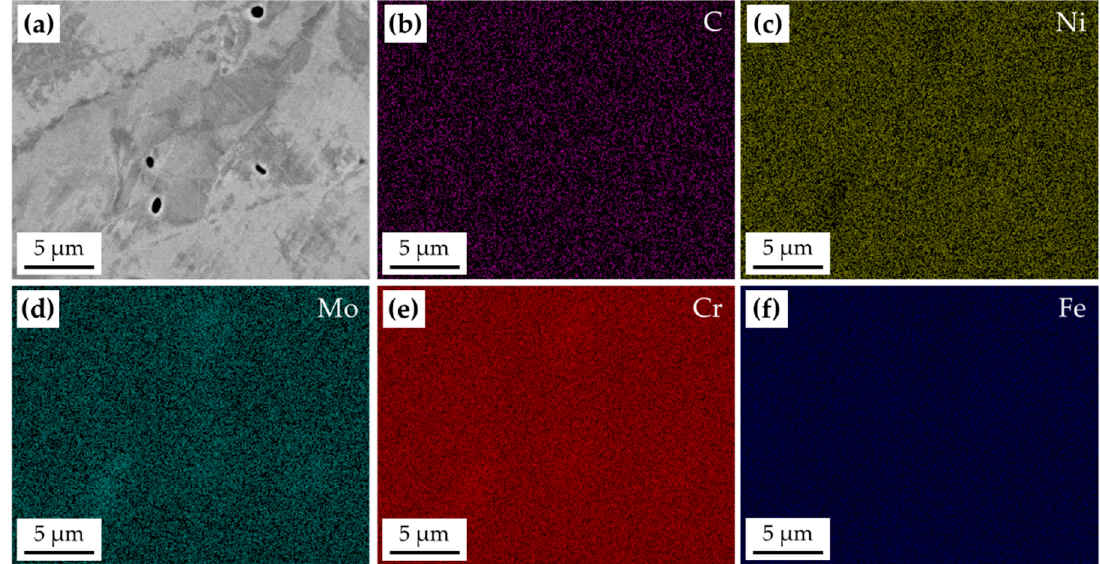
Figure 8. Compositional mapping of sample argon-2.2. ( a ) SEM image; ( b ) carbon; ( c ) nickel; ( d ) molybdenum; ( e ) chromium; and ( f ) iron.